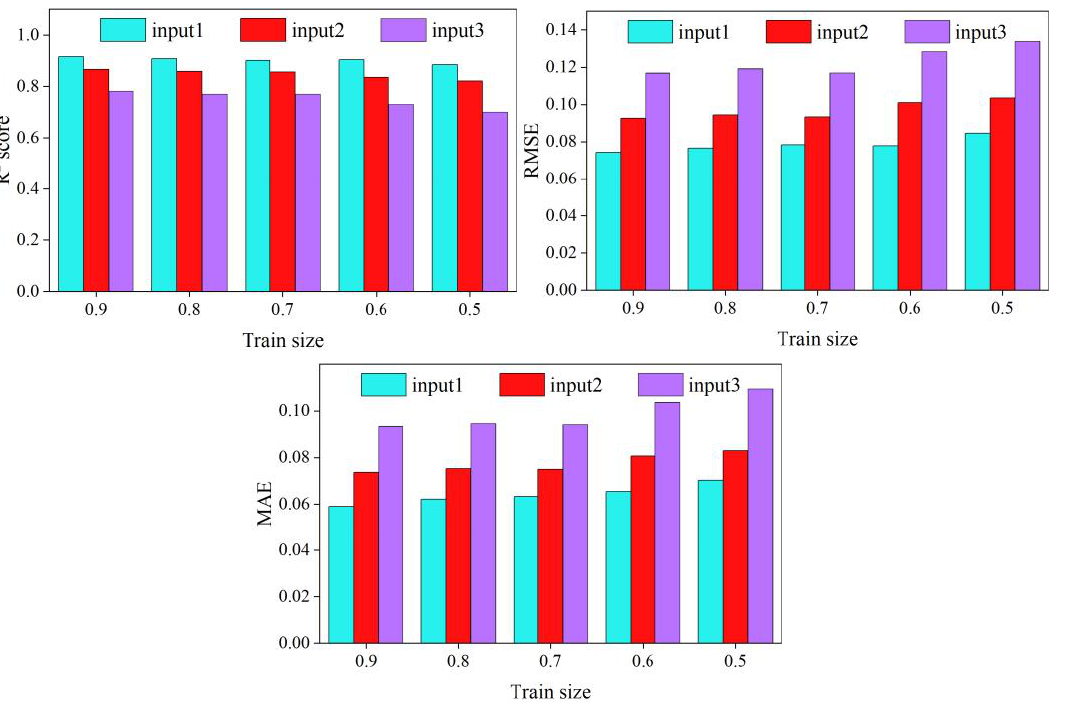
Figure 3. R 2 , RMSE, and MAE in cavity length prediction using the SVR model based on different input combinations.